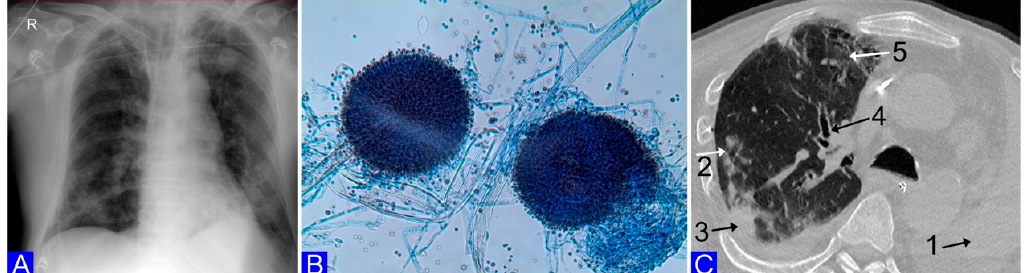
Figure 1. ( A ) Lung X-ray (Day 1). Bilateral pneumonia. ( B ) Aspergillus niger . Conidiophores of Aspergillus niger stained with lactophenol cotton blue (LCB), magnified 400×, provided by Zuzanna Tokarz MSc. ( C ) Lung HRCT (Day 15). Left lung atelectasis (1. right lung: suspected invasive pulmonary aspergillosis; 2. halo sign in early stage; 3. consolidation; 4. bronchiectasis; 5. ground-glass opacities).